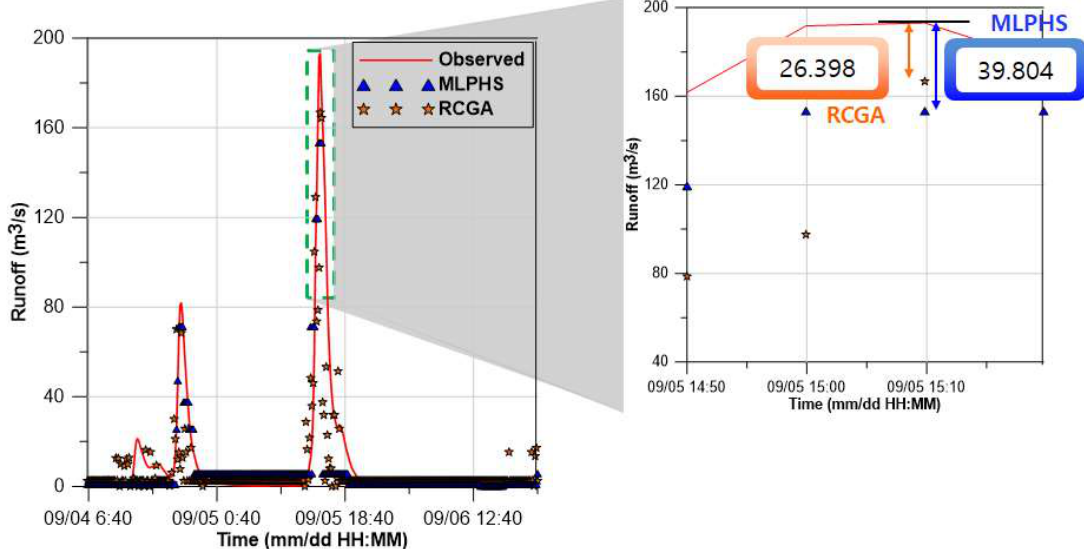
Figure 6. Comparison of the results obtained with the MLP using RCGA and the HS (MLPHS).